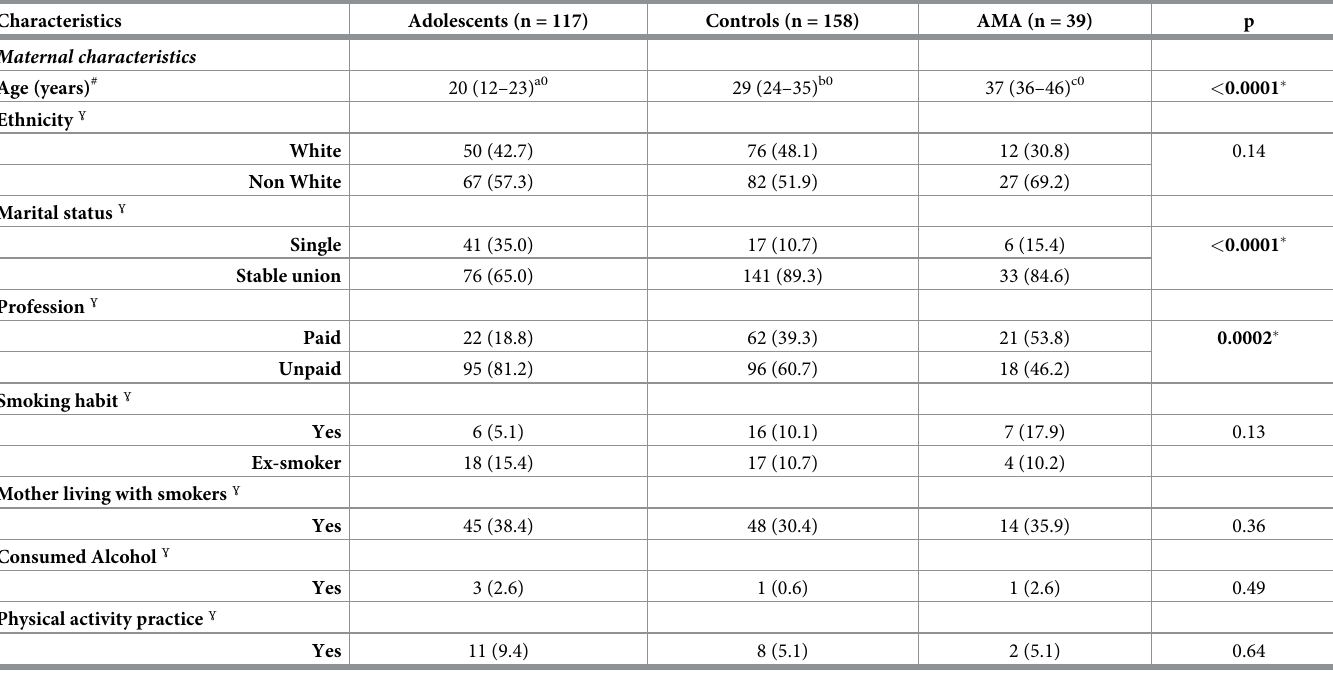
Table 1. Sociodemographic characteristics of adolescent, control, and advanced maternal age nursing mothers included in the study. Characteristics